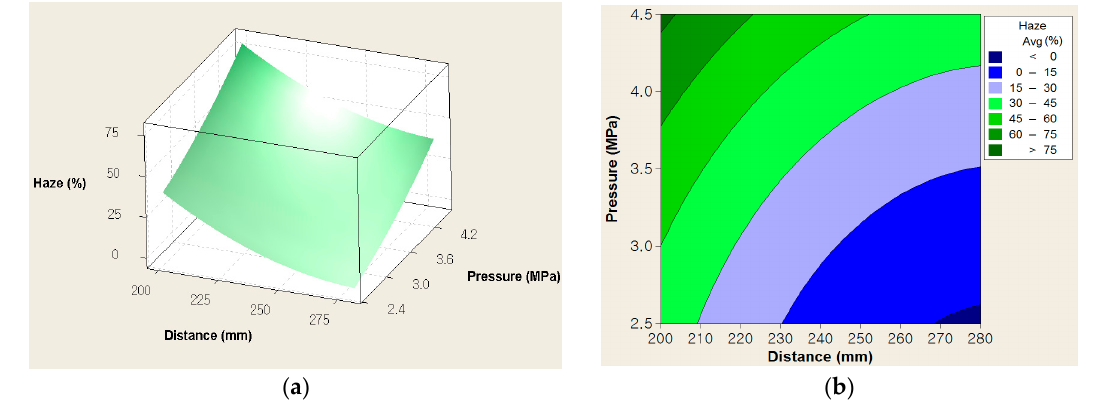
Figure 2. Effects of the distance of the nozzle from the surface and the pressure of the nozzle on the haze (motor speed was hold at 10 RMP): ( a ) 3D surface plot; ( b ) contour plot.